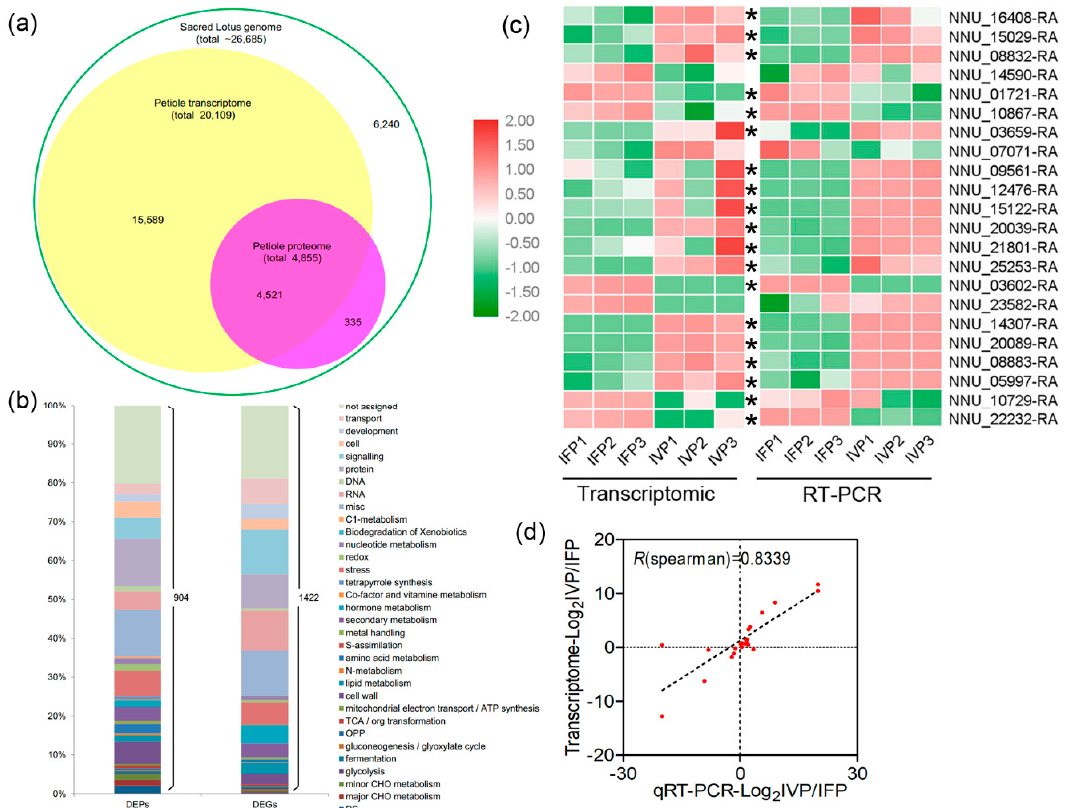
Figure 4. Comparison of protein and transcript abundance in lotus petioles. ( a ) Congruency between the detected transcripts and proteins of lotus petioles; ( b ) functional classification and distribution of differentially expressed genes (DEGs) and differentially expressed proteins (DEPs); ( c ) heatmap of 22 selected genes performed by transcriptomic and RT-PCR data. Asterisk indicates genes have a similar expression pattern in transcriptomic and RT-PCR experiments; ( d ) correlations of gene expression between transcriptomic and RT-PCR data. R represents the Pearson correlations coefficient.